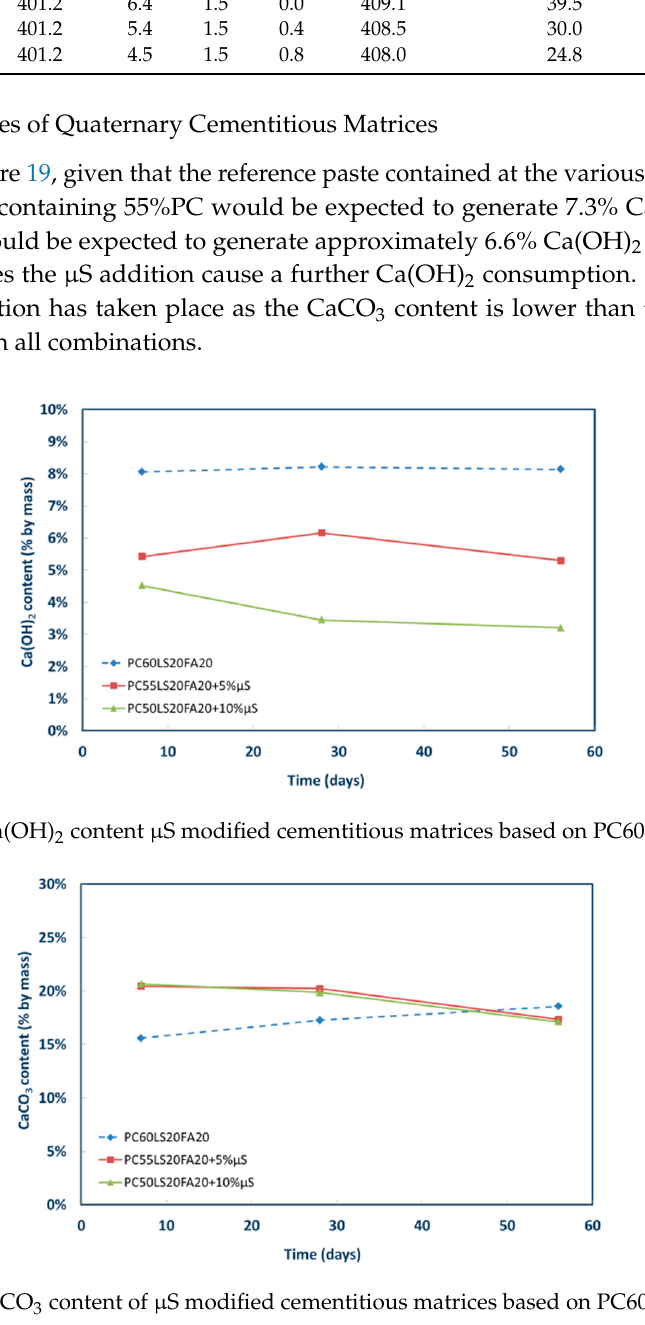
Figure 20. CaCO 3 content of μ S modified cementitious matrices based on PC60LS20FA20.